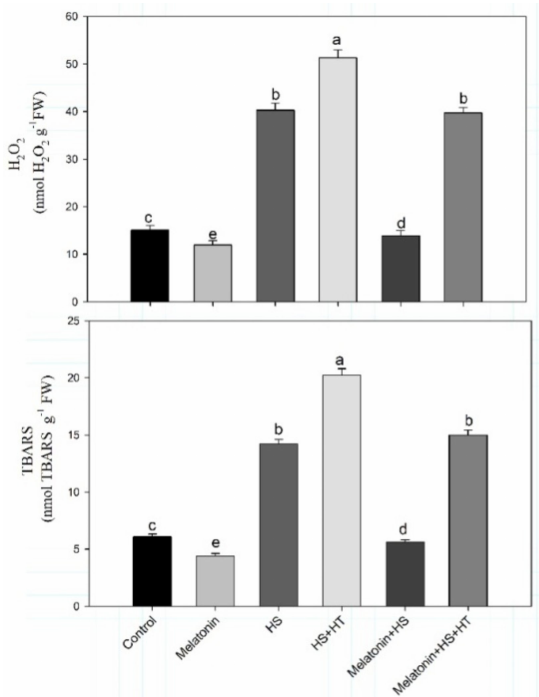
Figure 4. Content of H 2 O 2 and TBARS in wheat ( Triticum aestivum L. var. WH 542) leaves at 30 days after sowing (DAS). Plants were treated with melatonin (100 µ M) and/or HT (100 µ M) in the presence (40 ◦ C) or absence (25 ◦ C) of heat stress. Data are presented as means ± SE ( n = 4). Data followed by the same letter are not significantly different by LSD test at p < 0.05. H 2 O 2 , hydrogen peroxide; HS, heat stress; HT; hypotaurine; TBARS, thiobarbituric acid reactive